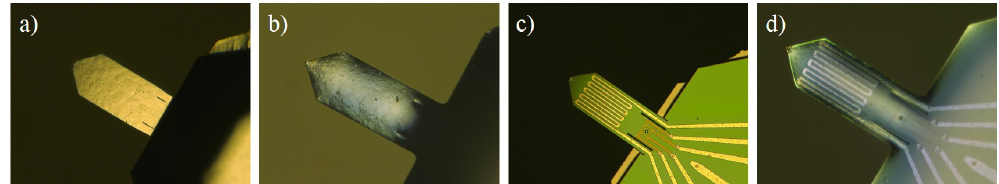
Figure 2. Optical microscope imaging of active probe ( a ) uncoated silicon surface, ( b ) coated silicon surface, ( c ) uncoated surface with heating wires, ( d ) coated surface with heating